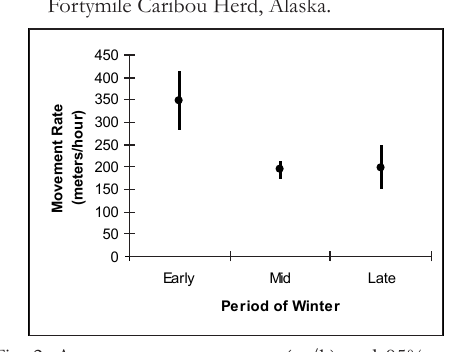
Fig. 2. Average movement rates (m/h) and 95% confi- dence intervals of female caribou for different pe- riods of the winter, 1998–1999, Fortymile Caribou Herd, Alaska.